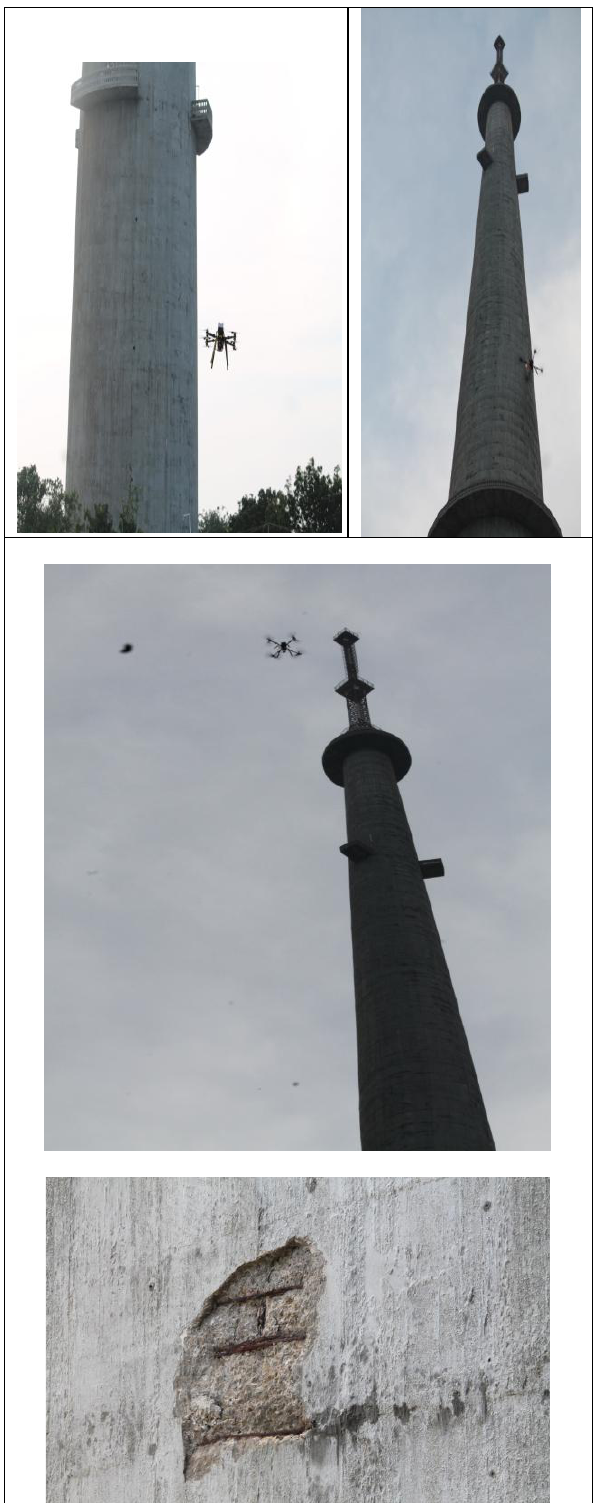
Figure 12. Inspection of RCC tower using Dhaksha UAS